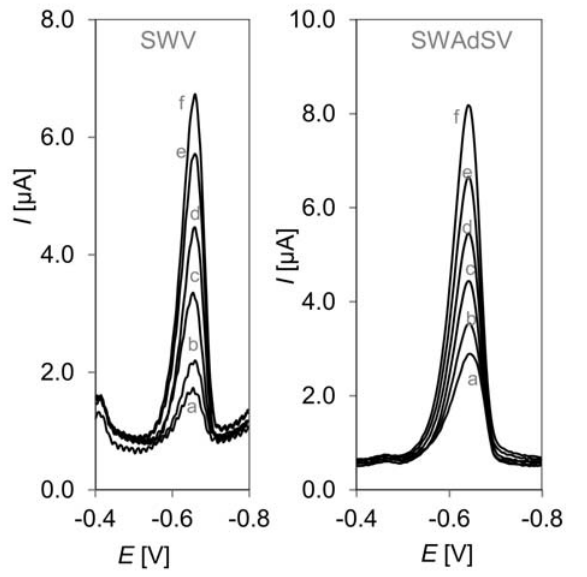
Figure 4. SW voltammograms of aclonifen in borax buffer with p- H 9.2, herbicide concentrations: (a) 0.1, (b) 0.2, (c) 0.4, (d) 0.6, (e) 0.8, (f) 1.0 μmol L –1 (SWV); (a) 0.01, (b) 0.02, (c) 0.04, (d) 0.06, (e) 0.08, (f) 0.10 μmol L –1 (SWAdSV). The other experimental con- Figure 5. Voltammograms of aclonifen determination in spiked ri- ditions were: SW amplitude E = 50 mV, step potential Δ E = 5 m- ver samples using the standard addition method (s – sample; 1, 2, sw = V, and frequency f = 150 Hz; and additionally, for SWAdSV, t 3 – standard additions). Experimental conditions are the same as in acc 45 s and E = –0.2 V. Fig. 4. acc